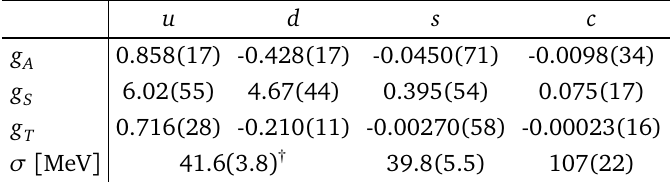
∆Σ q for the u (upper), the d (center) Figure 9: We show the intrinsic quark spin 1 2 and s quarks (lower) as a function of the pion mass. Open symbols do not include the disconnected contribution. Table 1: Single flavor charges and σ -terms from the cB211.072.64 ensemble. ( † ) In the case of u and d quarks we give σ π of relevance to N